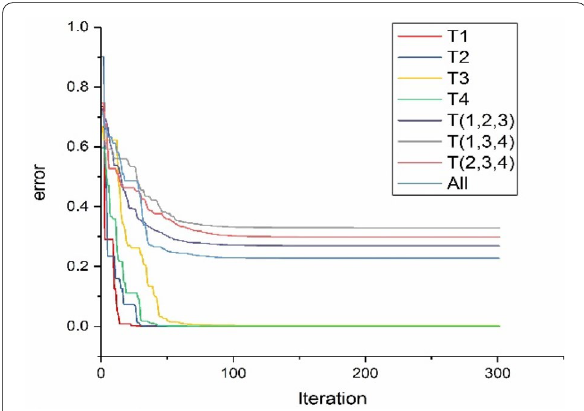
Figure 7 Error iteration curve for each